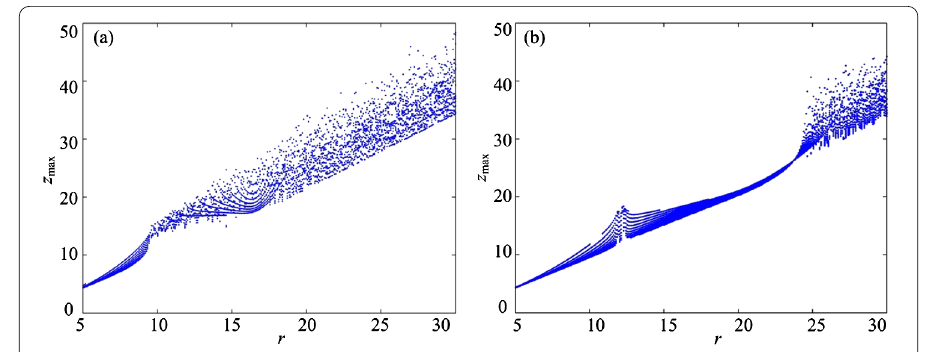
Figure 3 Bifurcation diagrams of the fractional-order financial risk system with parameter r varying ( a ) q 1 = q 2 = q 3 = 0.98 and r varying; ( b ) q 1 = q 2 = q 3 = 0.95 and r varying